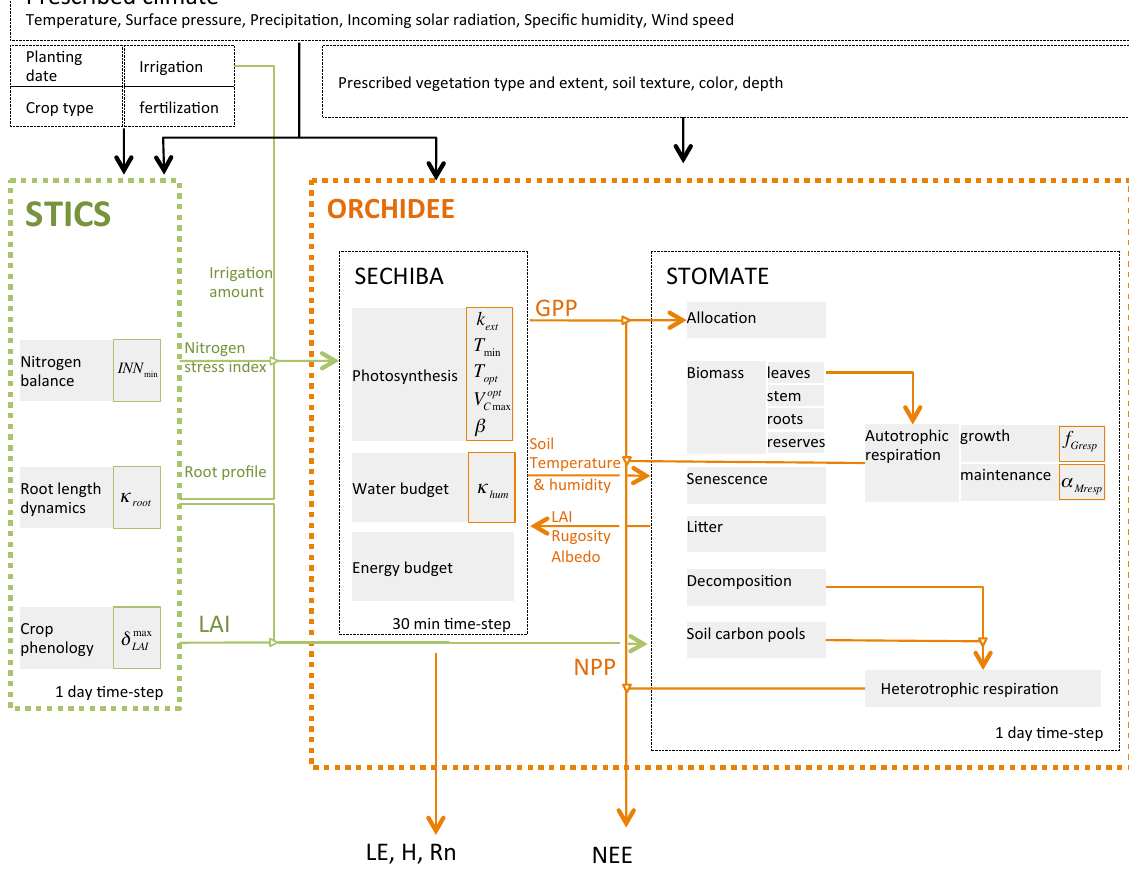
types instead of a single crop, as is the case here, and some- times used for optimization studies, therefore requiring wide enough ranges within the model’s domain of applicability (Groenendijk et al., 2011; Kuppel et al., 2012). By using overestimated ranges for input parameters, we estimate an upper bound for the value of the uncertainty on output vari-